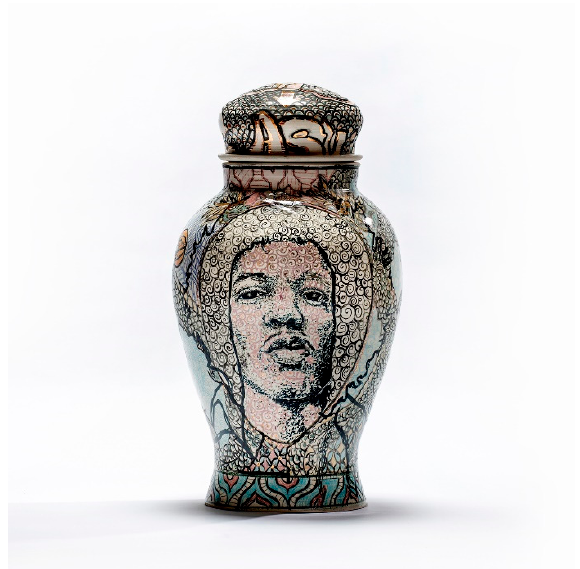
Figure 3. Method Man and Jimi Hendrix, 2018 , Earthenware and china paint, 13 × 13 × 26 in. Image by KeneK Photography, courtesy of Wexler Gallery.